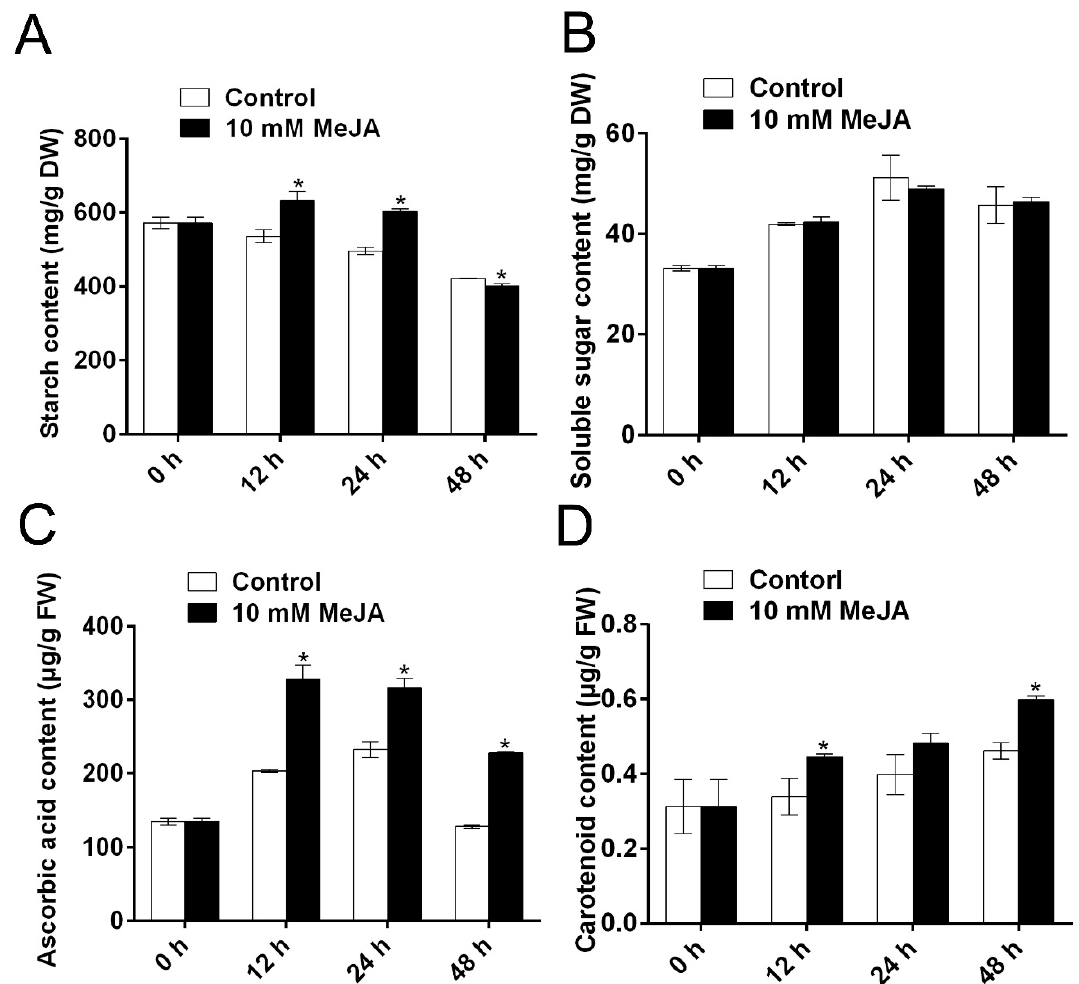
Figure 4. The modulation of MeJA treatment on the quality of cassava tuberous roots during PPD. The concentrations of starch content ( A ), soluble sugar content ( B ), ascorbic acid content ( C ), and carotenoid content ( D ) in cassava tuberous roots during PPD progression. Data are means ± SD calculated from three biological replicate samples. Asterisk symbols (*) indicate significant differences according to Duncan’s multiple range test at p < 0.05 at the same time.